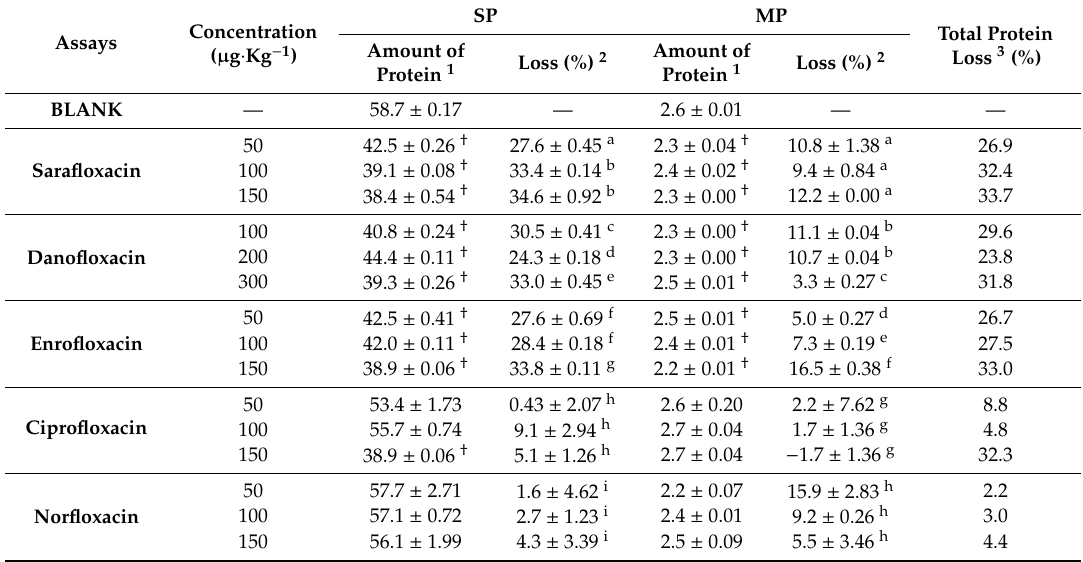
Table 1. Loss of solubility calculated by protein fraction from blank and treated